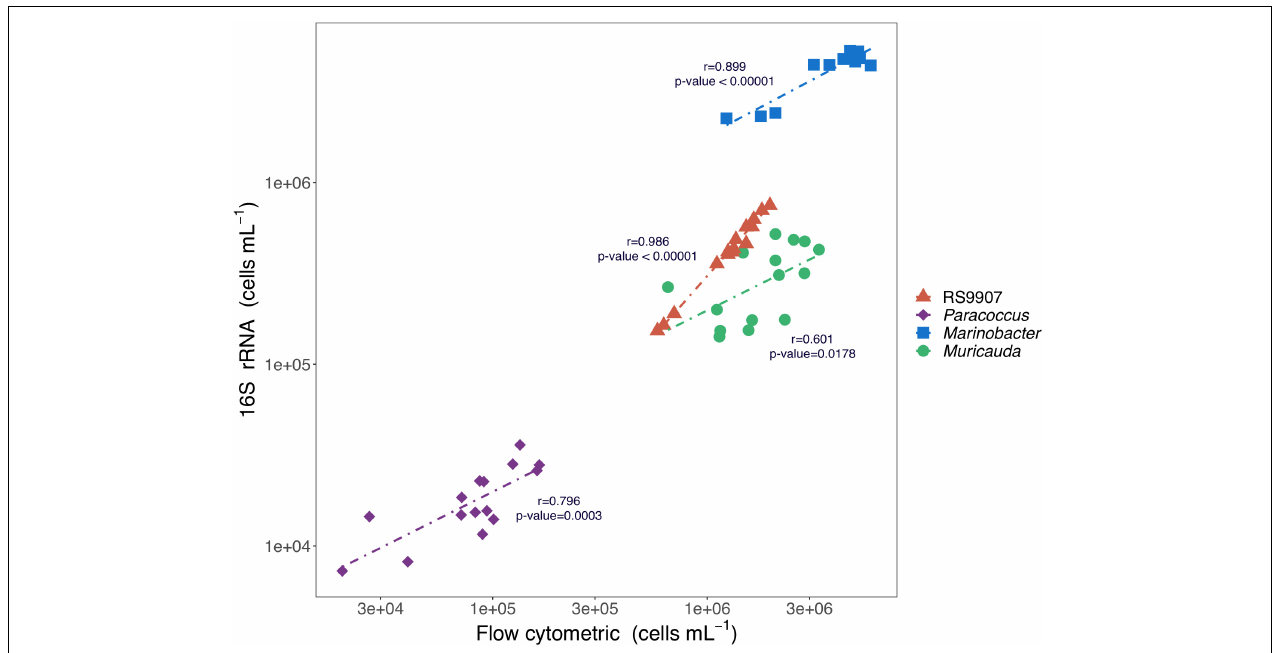
FIGURE 2 | Relationships between the 16S rRNA gene-based cell abundances (i.e., percent reads multiplied by total bacterial abundance as determined by flow cytometry) of Synechococcus RS9907, Paracoccus , Marinobacter , and Muricauda and the flow cytometric abundances of Synechococcus and the 3 major clusters of heterotrophic cells shown in Supplementary Figure 1 for all replicates and temperatures after 48 h incubation of experiment